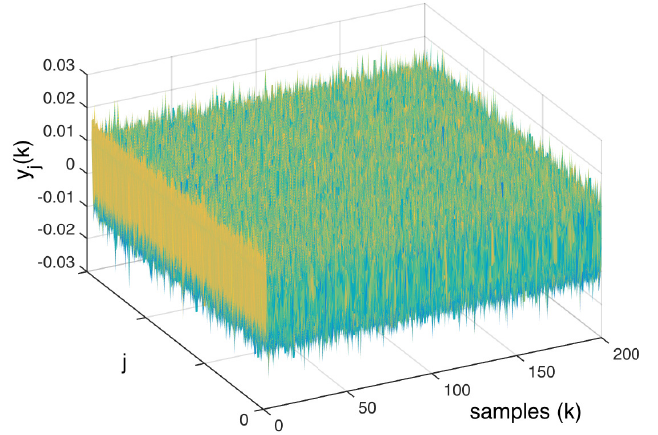
Figure 8. Signals y j ( k ) aligned to be